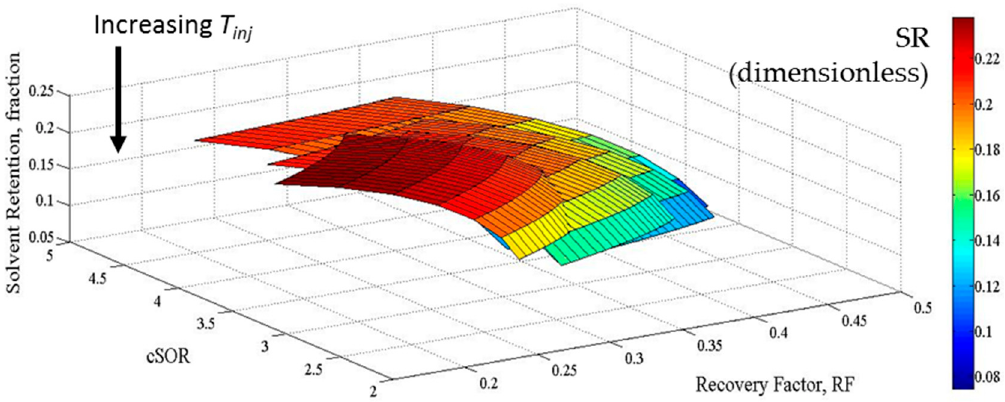
Figure 7. Surface plots of the three response functions, i.e., RF, cSOR, and SR, in three-dimensional objective space, which corresponds to four values of steam (without solvent) injection period (6, 12, 18, and 24 months).